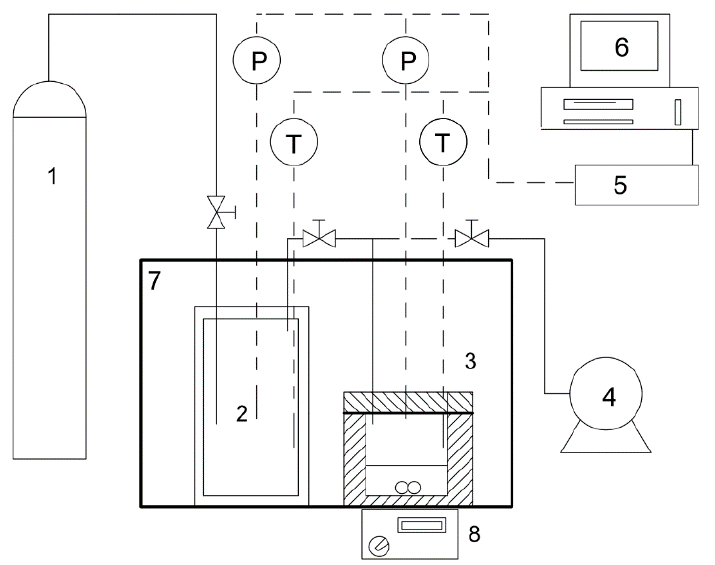
Figure 1. Schematic diagram of CO 2 hydrate forming device. 1 Gas cylinder; 2 buffer tank; 3 high- pressure kettle; 4 vacuum pump; 5 data collector; 6 computer; 7 thermostatic bath; 8 magnetic stir- rer.